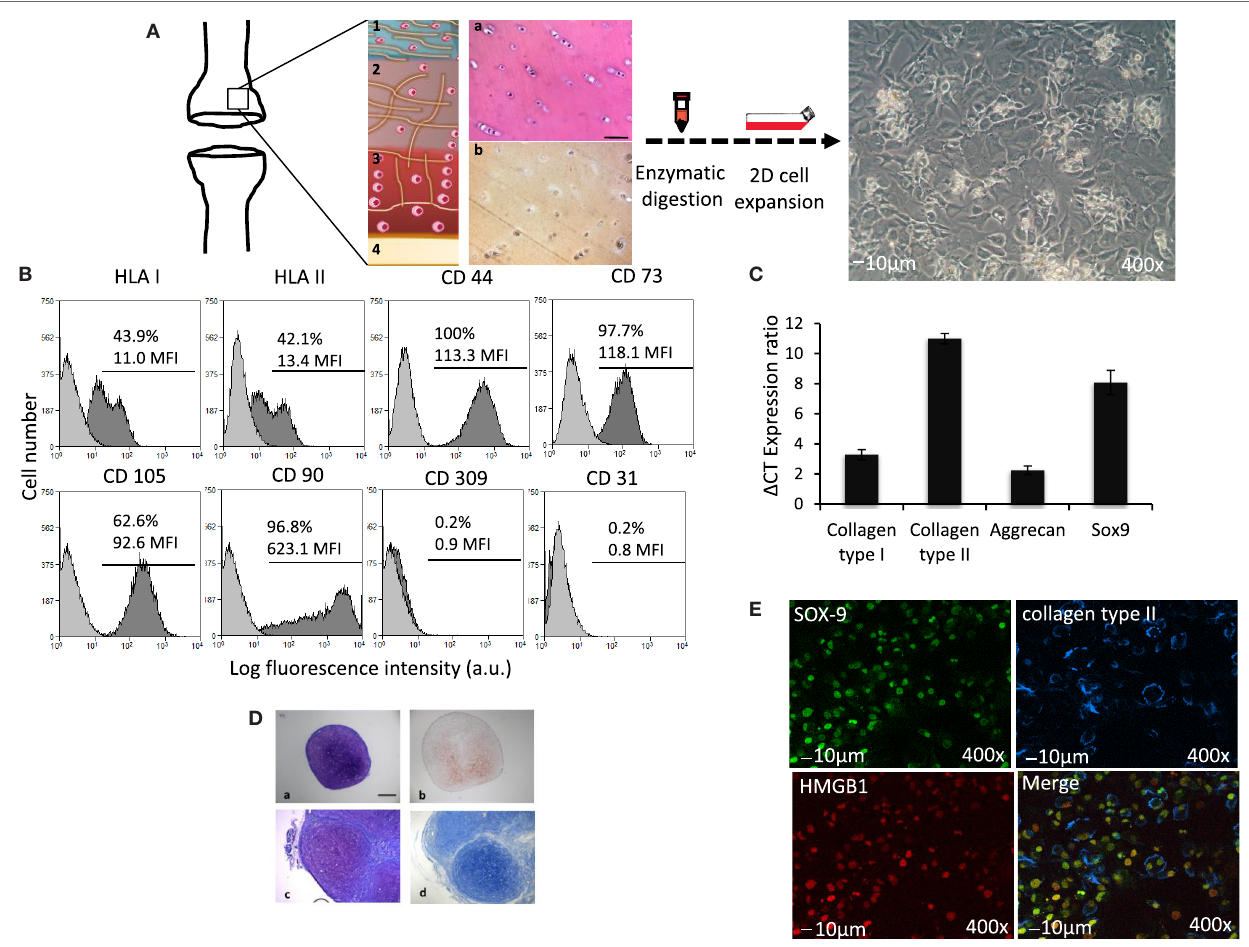
FigUre 1 | Phenotypic features of hac . (a) Schematic representation of surgical specimens of articular cartilage (on the left), enzymatic digestion and 2D cell expansion in culture (middle) and images of cultured hAC (on the right). 1, 2, 3, and 4 represent schematically the anatomic architecture of cartilage divided by zones: (1) superficial tangential; (2) middle; (3) deep, and (4) calcified cartilage zone. Histological explants characterization: (a) hematoxylin and eosin and (b) immune detection of collagen type II. (B) Phenotype of hAC assessed by cytofluorimetry with mAbs to the indicated surface molecules (HLA-class I, HLA-class II DR antigens, CD44, CD73, CD105, CD90, CD309, and CD31). Results are shown as log fluorescence intensity vs. number of cells. In each subpanel are shown the negative control (light gray histogram) and the expression of the indicated antigens (dark gray histogram). In each panel are indicated the % of positive cells and their mean fluorescence intensity (MFI) in arbitrary units (a.u.). (c) Δ CT ratio of mRNA expression in cultured hAC of either collagen type I or type II, or aggrecan or sox-9 transcription factor and GAPDH housekeeping gene. (D) Histological staining of 3D pellet culture cross sections. (a,b) In vitro pellet formed by human articular chondrocytes. (a) toluidine blue staining, (b) immunohistochemical expression of collagen type II. (c,d) In vivo subcutaneous implantation of pellets. Pellets were formed by hAC, after 2 weeks in culture, these pellets were then implanted in nude mice. (c) toluidine blue staining, (d) alcian staining. Scale bar = 100 μ m. (e) Expression of nuclear Sox9 (green) and extracellular collagen II (blue) on hAC assessed by confocal microscopy. The expression of HMGB1 (red) as a nuclear marker is shown to identify nucleus. The merge image is also shown. Bar = 10 μ m. 400 ×